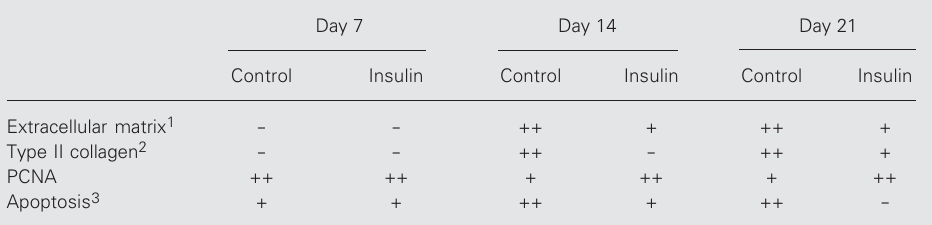
Table 1. Semiquantitative analysis of selected histological indexes demonstrating the deposition of extracel- lular matrix, expression of type II collagen, cell proliferation and apoptosis with time in